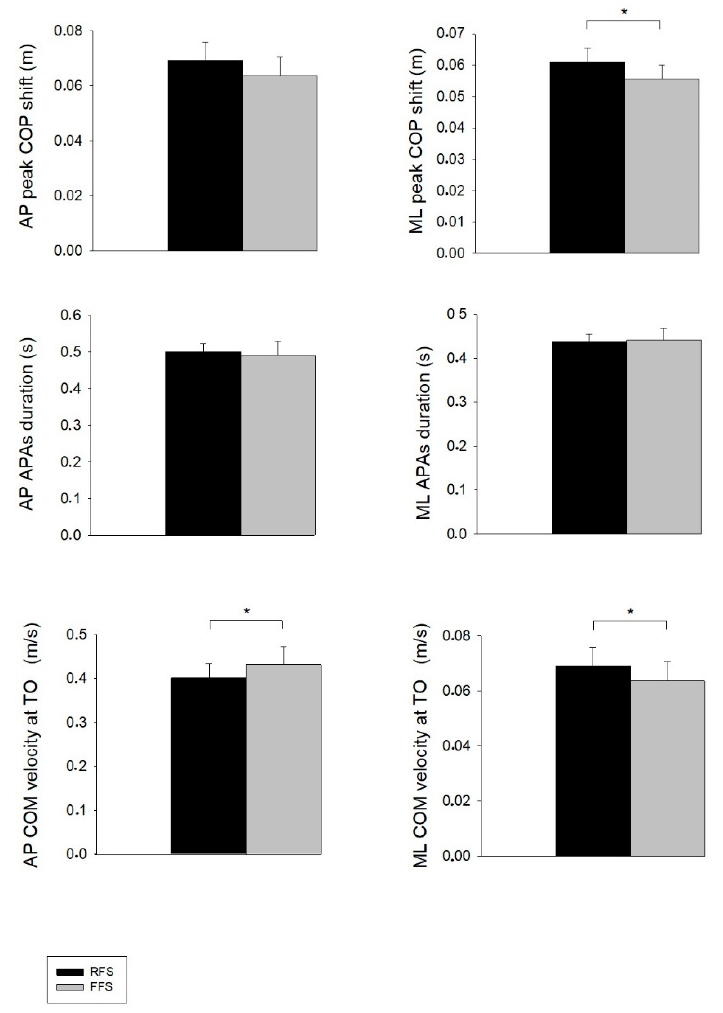
Figure 4. Effects of swing-foot strike pattern on selected APA parameters. Reported are mean values (all participants together) + 1 SE. APAs: anticipatory postural adjustments; TO: toe-off; COP: centre of pressure; COM: centre of mass; RFS: rearfoot strike condition; FFS: forefoot strike condition. Bars at the left side: mediolateral (ML) direction. Bars at the right side: anteroposterior (AP) direction. * Indicates a significant difference between bars.